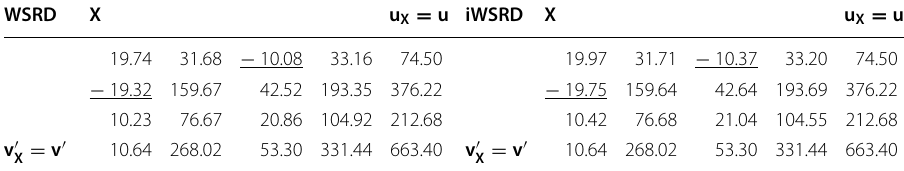
With the same location of underlined matrix elements as in Table 10